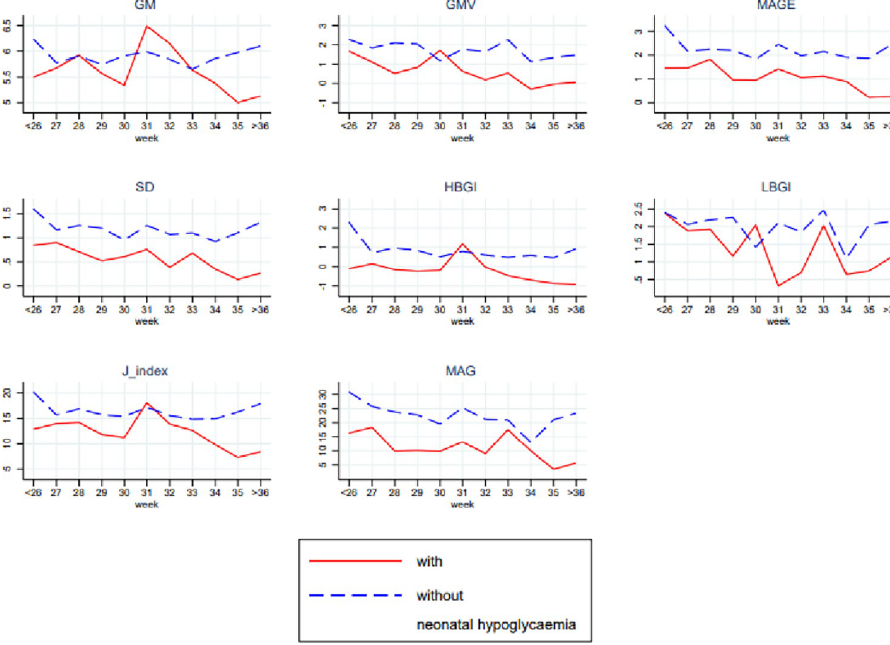
Fig 2. Trends in parameters of glycaemic variability by neonatal hypoglycaemia. GM = Glycaemic Mean; GMV = Glycaemic Mean Value; HBGI = High Blood Glucose Index; LBGI = Low Blood Glucose Index; MAG = Mean Absolute Glucose; MAGE = Mean Amplitude of Glucose Excursions; SD = Standard Deviation. Adjusted values reported (see the Statistical analysis sub-section for details).